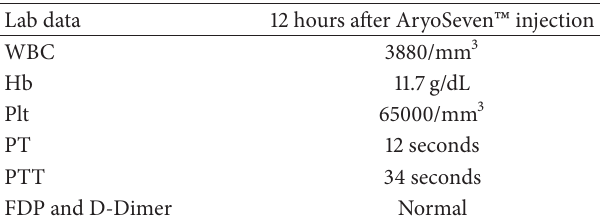
Table 4: Lab data 12 hours after administration of